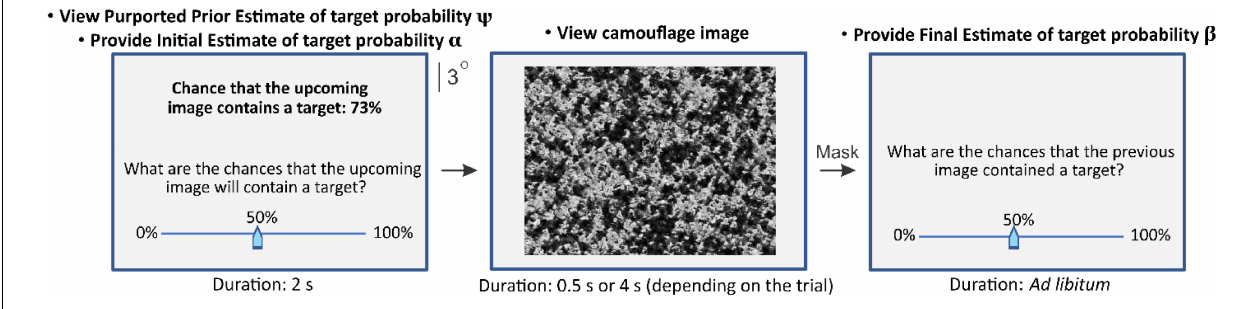
FIGURE 1 | Task paradigm of Experiment 1. The three panels from left to right in this figure are shown in the temporal order they were presented during each trial. The starting position of the on-screen slider ( left and right panels, bottom ) was always 50%. Panels not drawn to exact scale. See text for details.